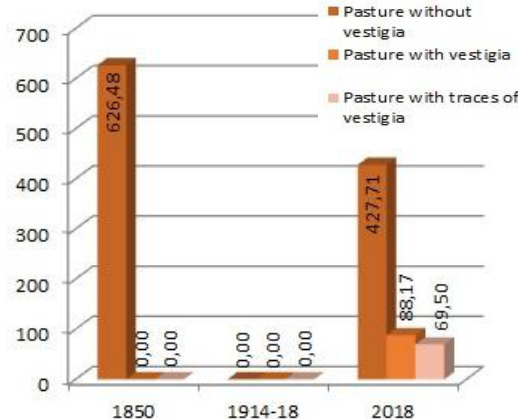
fragile traces of the remains.